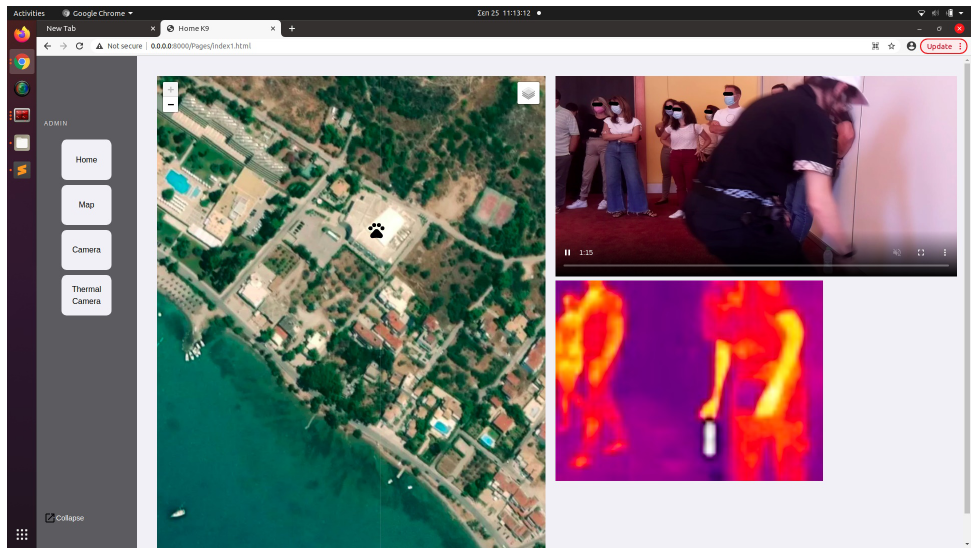
Figure 8. The K9 Vest user interface showing the localization on map along with the HD and thermal camera